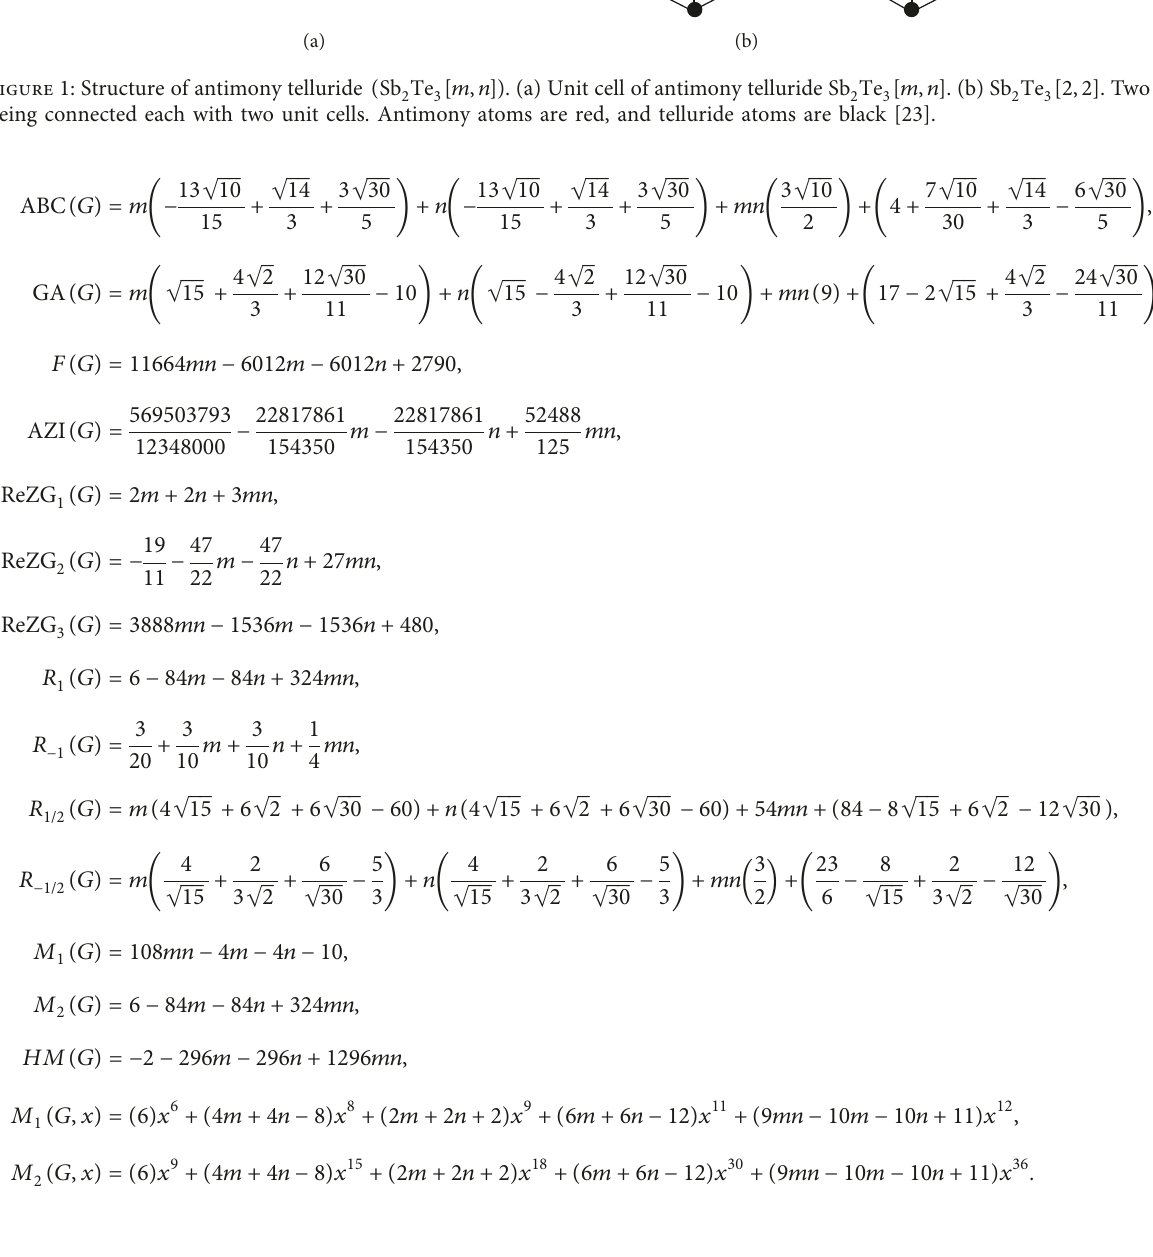
[ m, n ]) . (a) Unit cell of antimony telluride Sb Te 2 3